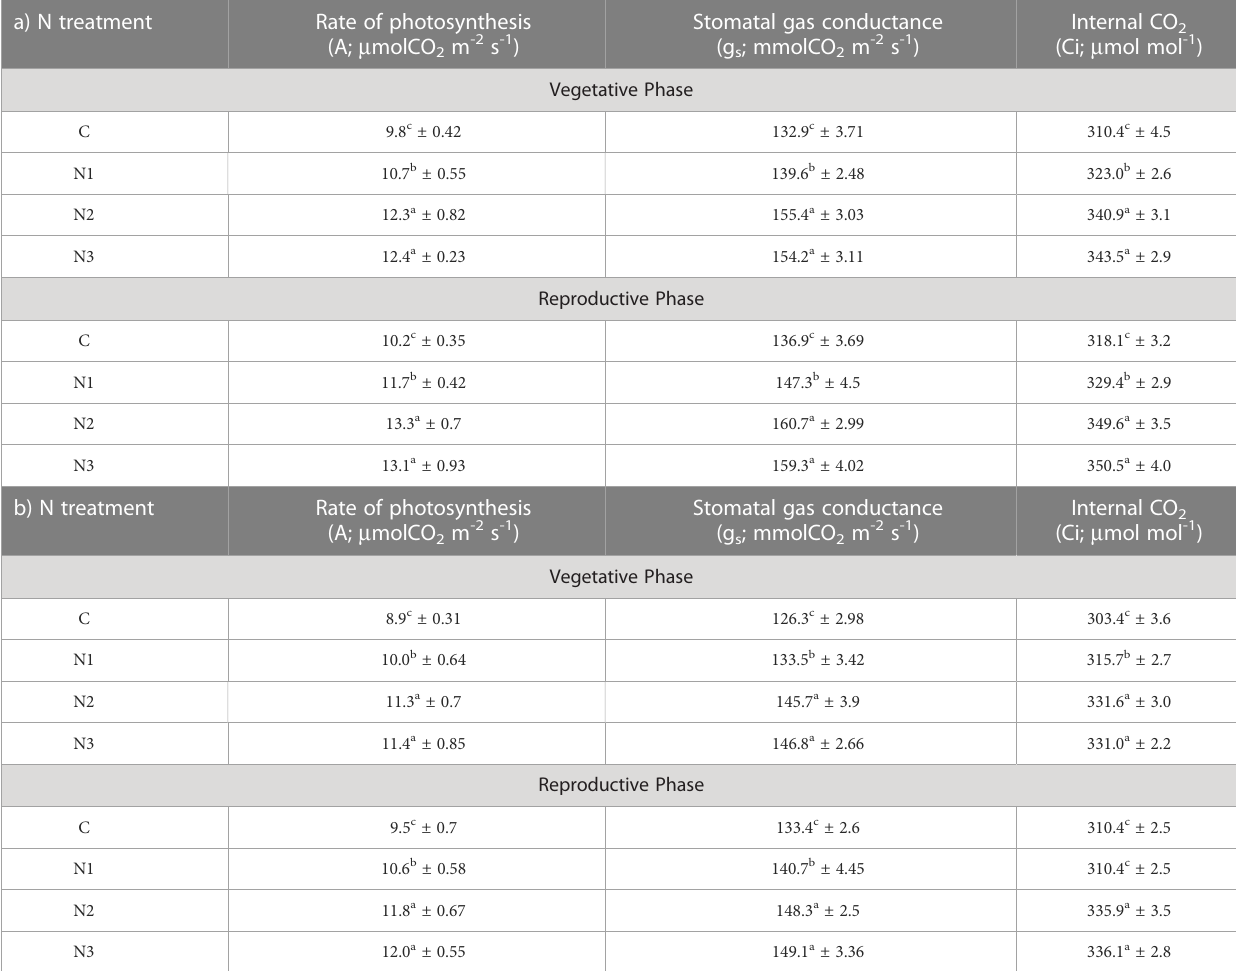
TABLE 2 Effect of N treatment (C, control; N1, recommended N dose; N2, 1.5-times recommended N dose and N3, 2-times recommended N dose) on physiological parameters of Dolichos lablab L. under AO 3 at vegetative stage and reproductive